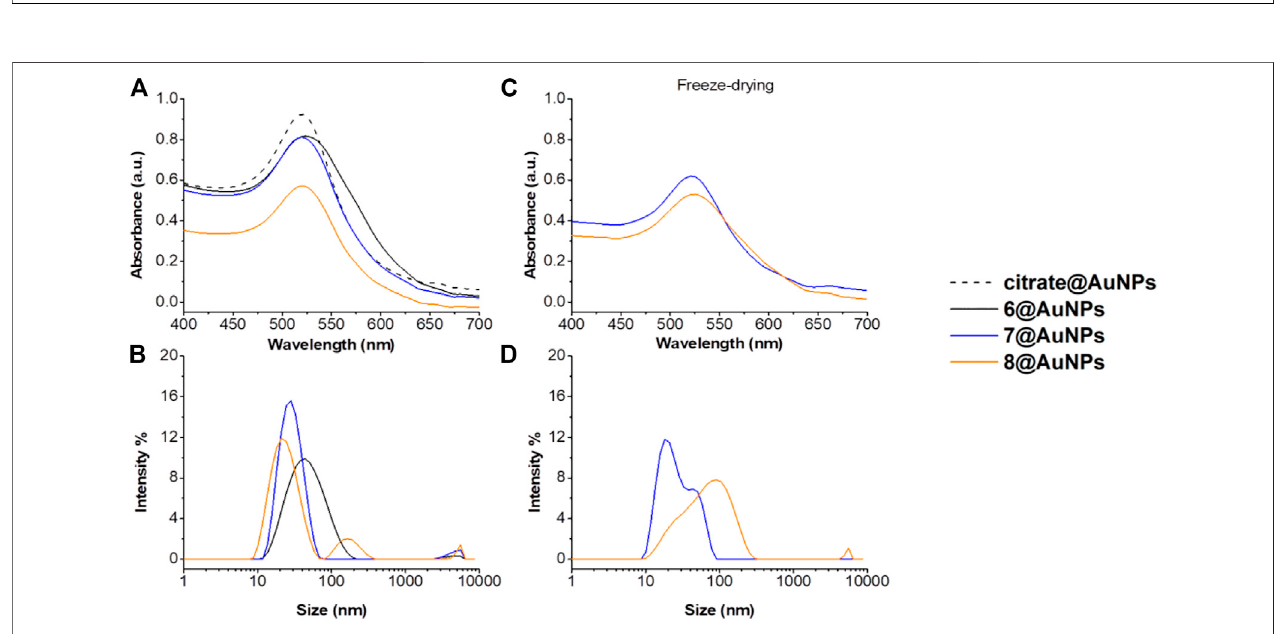
FIGURE 3 | (A) Absorption spectra and (B) size distribution by intensity of citrate@AuNPs (dash) and functionalized-AuNPs with peptides 6 (black), 7 (blue), 8 (orange). Mean DLS results are given for three different measurements. The hydrodynamic diameter is found 22.7 ± 0.2 nm PdI 0.2 ± 0.02 for citrate@AuNPs, 52.1 ± 4.5 nm PdI 0.3 ± 0.04 for 6 @AuNPs, 27.4 ± 0.3 nm PdI 0.2 ± 0.03 for 7 @AuNPs, and 29.2 ± 1.6 nm PdI 0.3 ± 0.02 for 8 @AuNPs. (C) Absorption spectra and (D) size distribution by intensity functionalized-AuNPs with peptides 7 (blue) and 8 (orange) after freeze-drying. Mean DLS results are given for three different measurements. The hydrodynamic diameter is found 22.4 ± 2.1 nm PdI 0.2 ± 0.04 for 7 @AuNPs, and 82.7 ± 3.6 nm PdI 0.3 ± 0.03 for 8 @AuNPs.